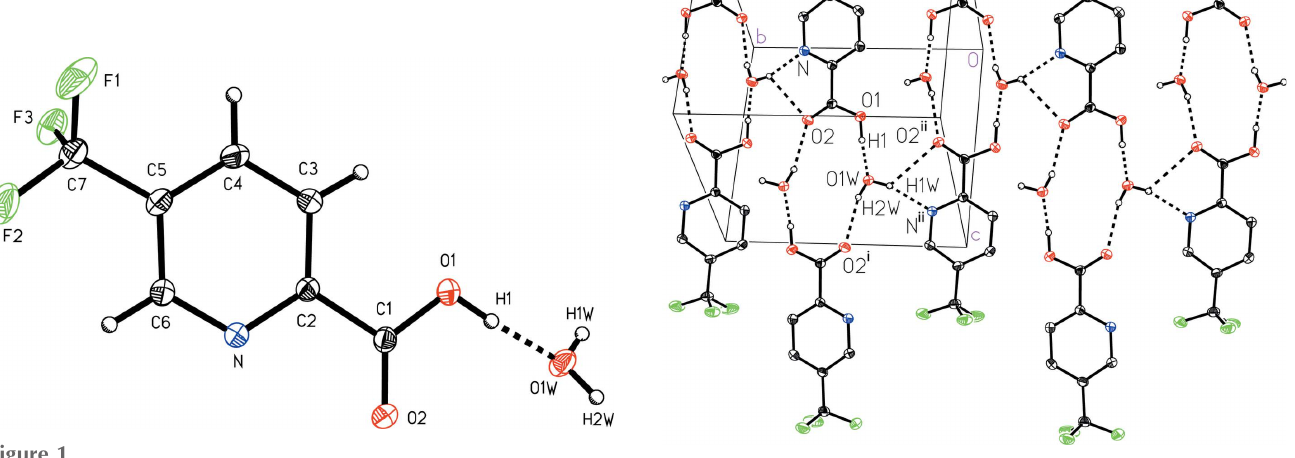
Figure 3 A view of a pleated strip formed between the water-bridged hydrogen- bonding dimers in 5-(trifluoromethyl)picolinic acid (I) hydrate.